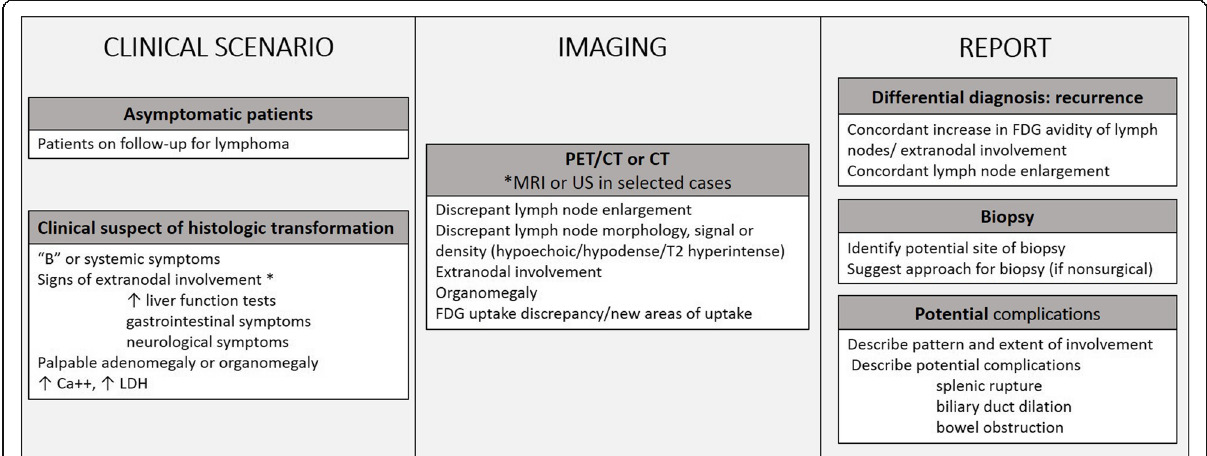
Fig. 9 Imaging algorithm for management of suspected histologic